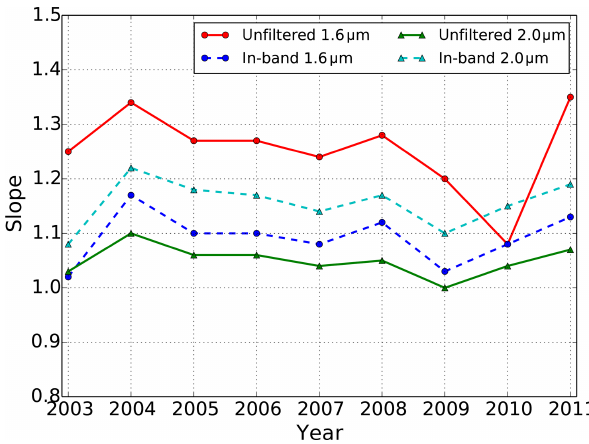
Figure 7. Slope of SABER 2.0 and 1.6µm volume emission rates vs. the corresponding simulations using SCIAMACHY data from 2003 to